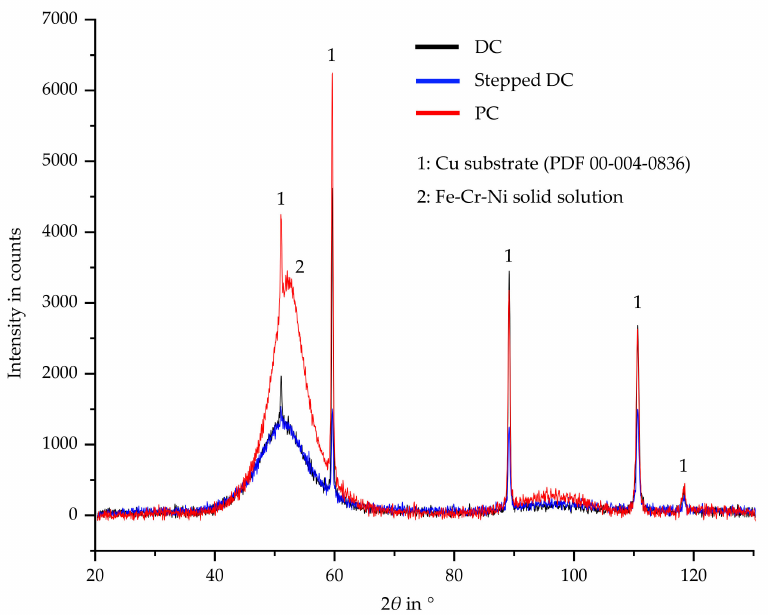
Figure 7. XRD measurements of electrodeposited Fe-Cr-Ni layers in dependence of current